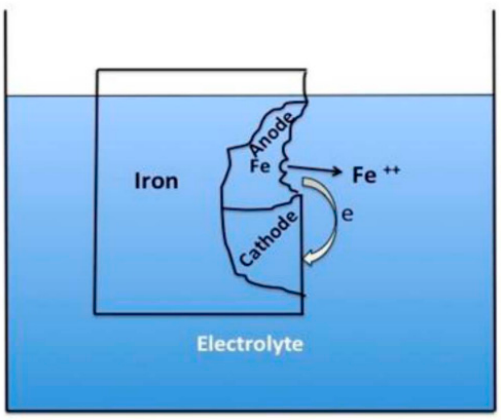
Figure 1. Local corrosion on steel surface